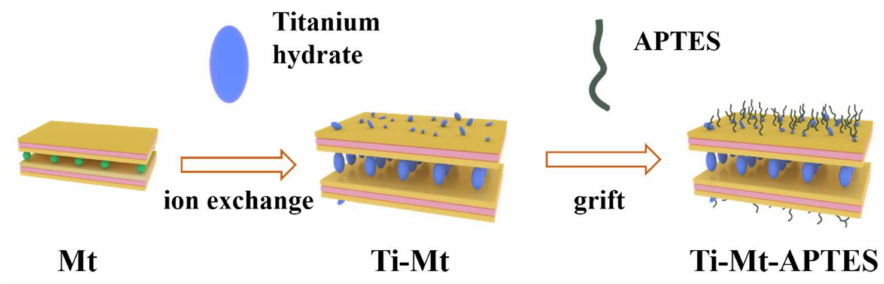
Figure 1. Preparation of Ti-Mt-APTES. Mt. Mt, montmorillonite; APTES,